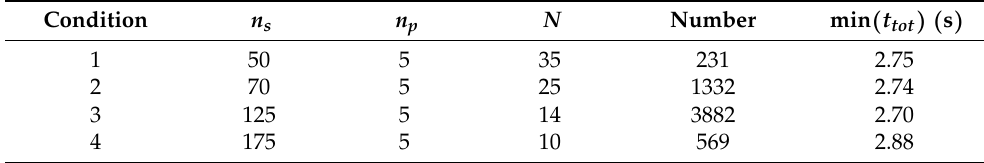
Table 7. Four battery pack structures in the solutions.